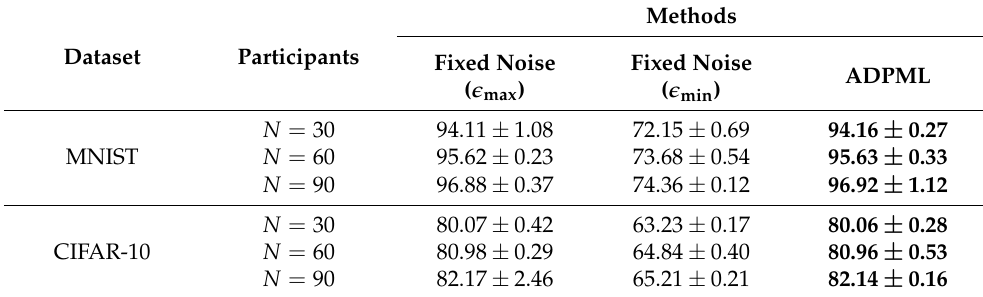
Table 3. The model accuracy of different strategies for 30, 60, and 90 participants.